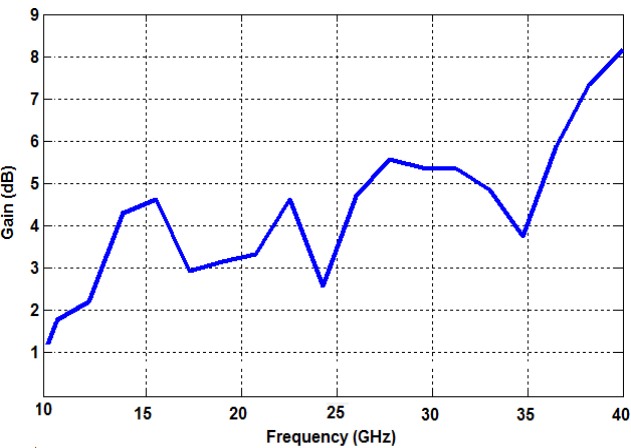
Figure 5. Voltage standing wave ratio (VSWR) values of the single element antenna.